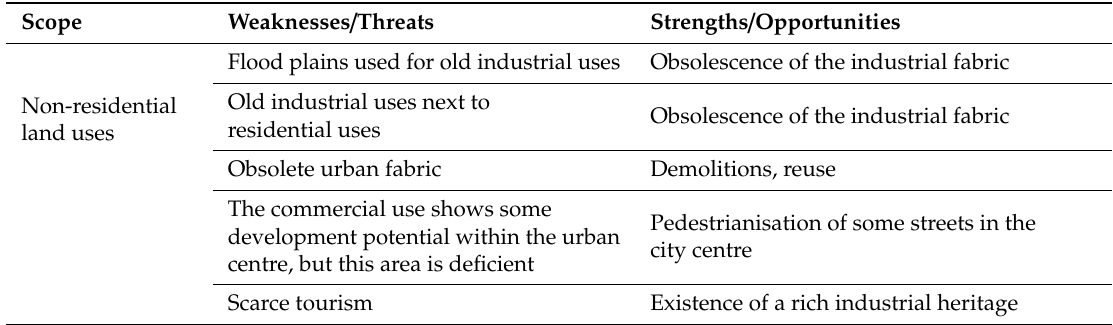
Table 1. Case study summary